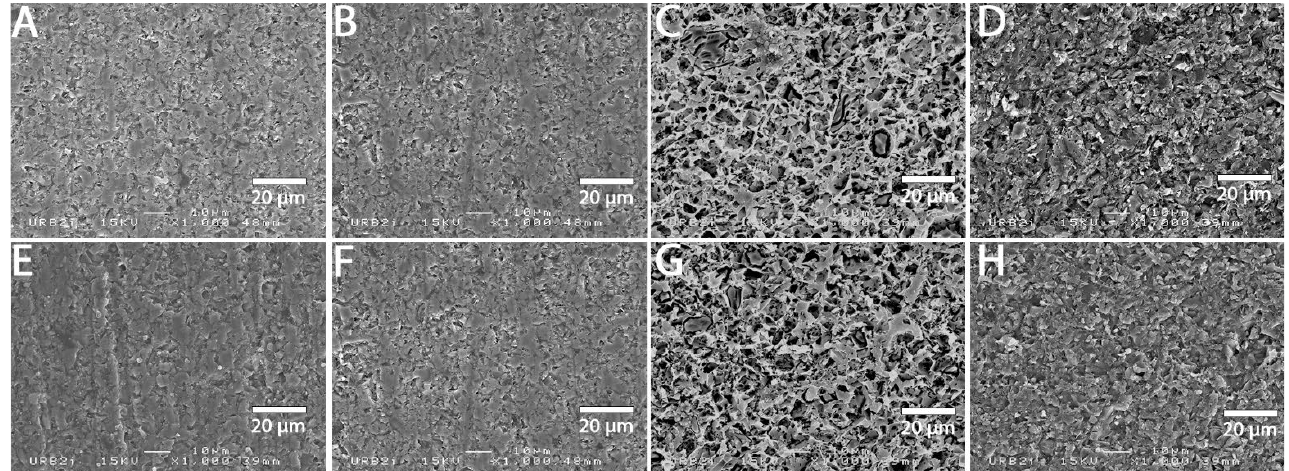
Figure 7. SEM micrograph for Tetric CAD surface (×1000 magnification) with the different surface treatments: ( A ) control; ( B ) polyacrylic acid; ( C ) hydrofluoric acid; ( D ) sandblasting; ( E ) 800 grit polishing + universal primer; ( F ) polyacrylic acid + universal primer; ( G ) hydrofluoric acid + uni- versal primer; ( H ) sandblasting + universal primer. Sandblasting surface treatment ( D , H ) shows a more irregular pattern surface than the other ones.